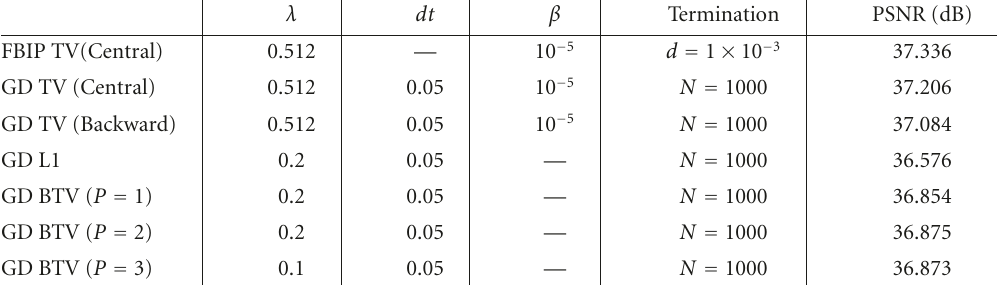
Table 4: Comparison with GD TV and BTV algorithms in the nonsynthetic “noise-free” case (5